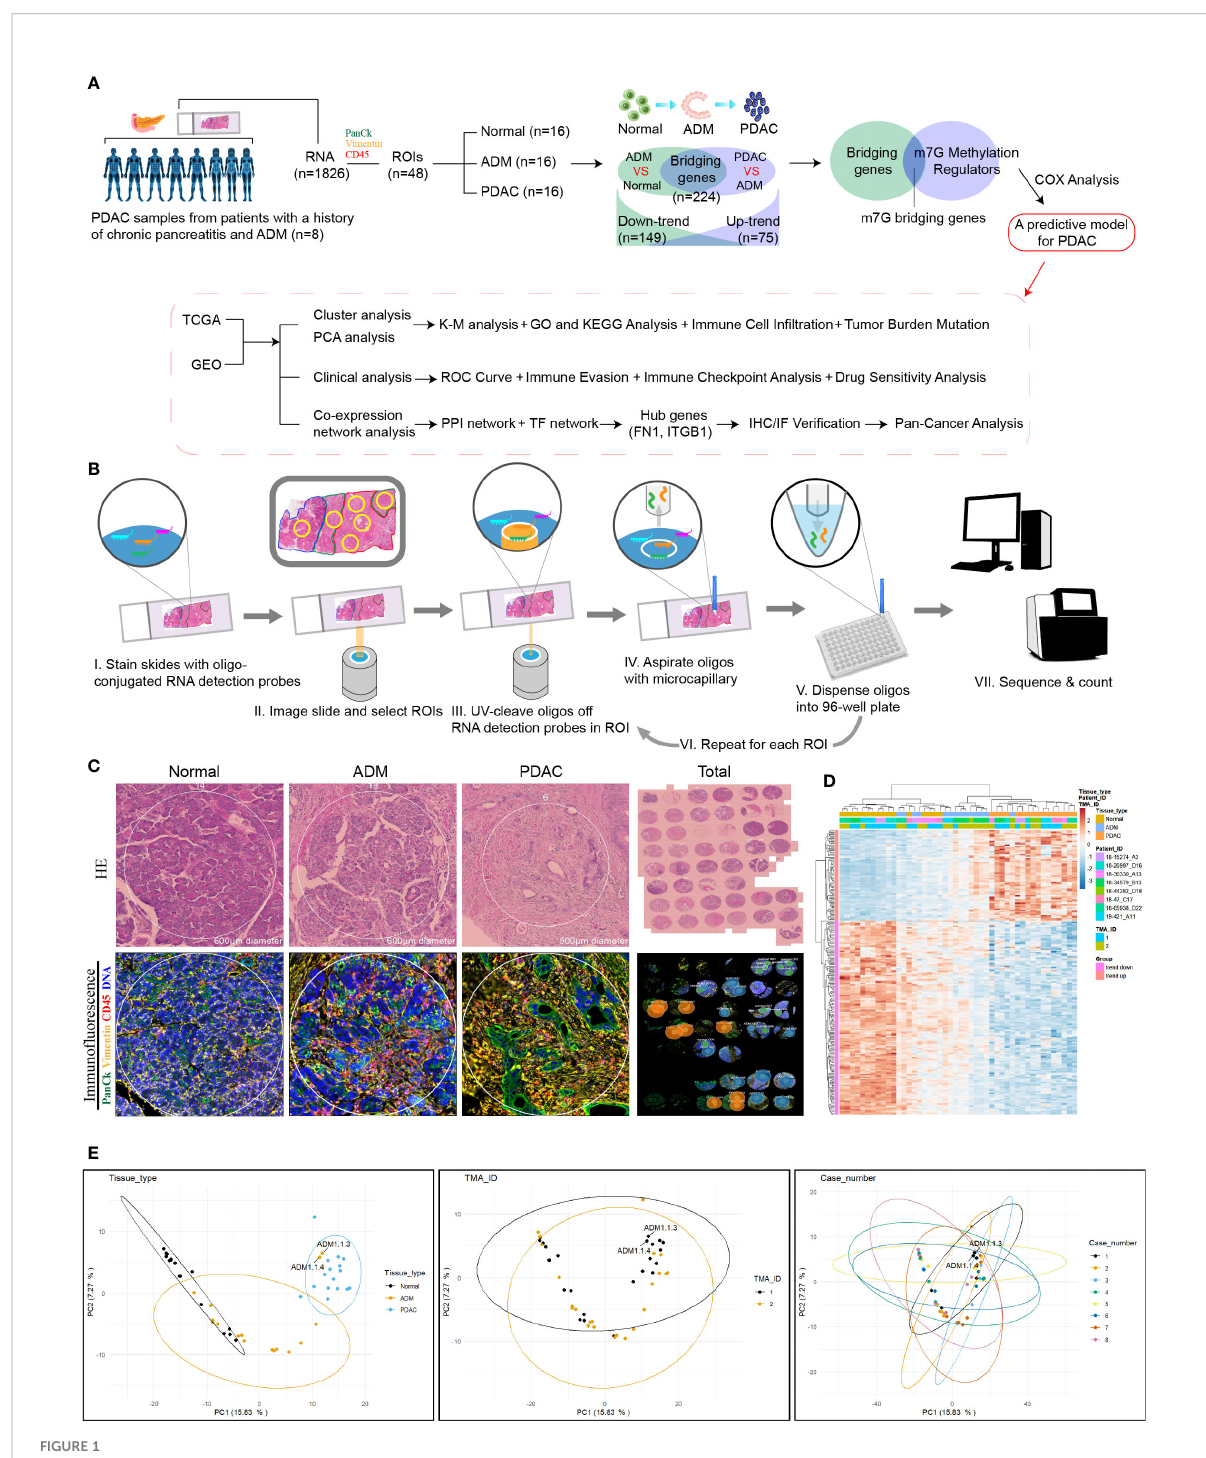
FIGURE 1 Digital spatial pro fi ling of pancreatic cancer FFPE samples from patients with a history of chronic pancreatitis and ADM. (A) Flowchart of the study. (B) Schematic overview of the DSP work fl ow. (C) Representative HE staining and IHC images from each group. (D) Heatmap of the 1826 detected genes. Cluster analysis indicated the clusters marked in different colors. (E) PCA analysis of tissues, slides and